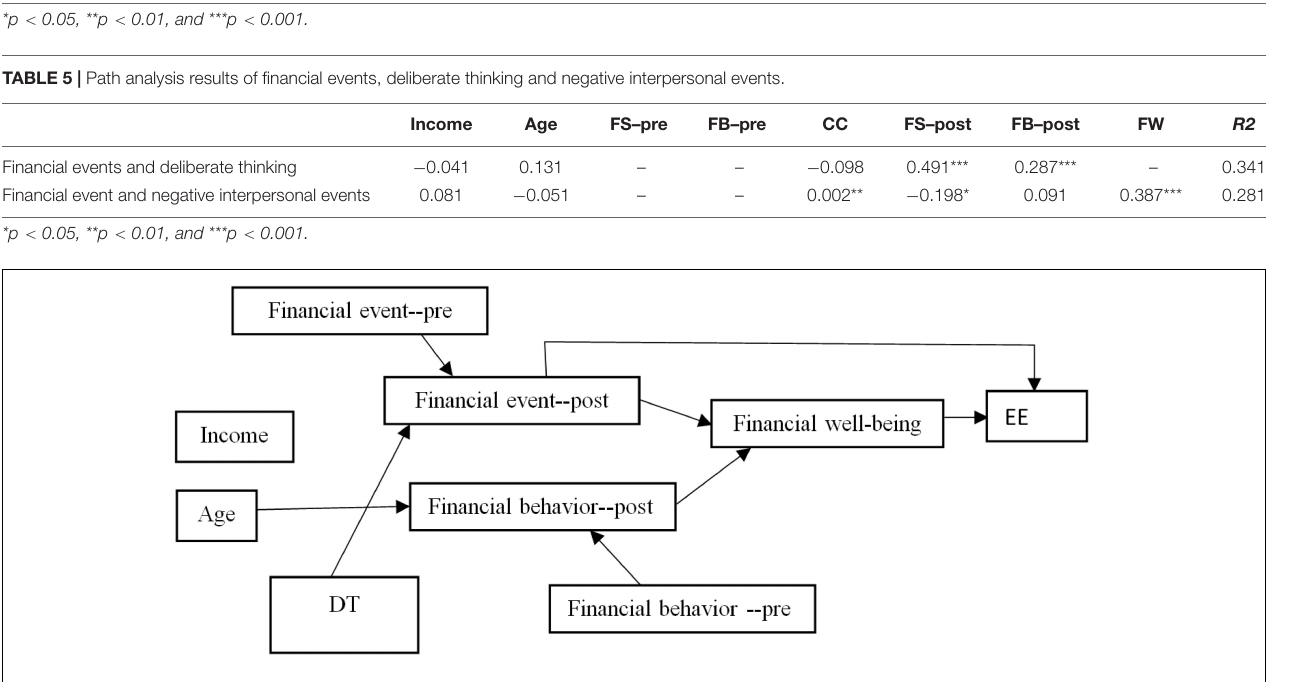
FIGURE 2 | Path analysis. EE, Emotional Exhaustion; DT, Deliberate